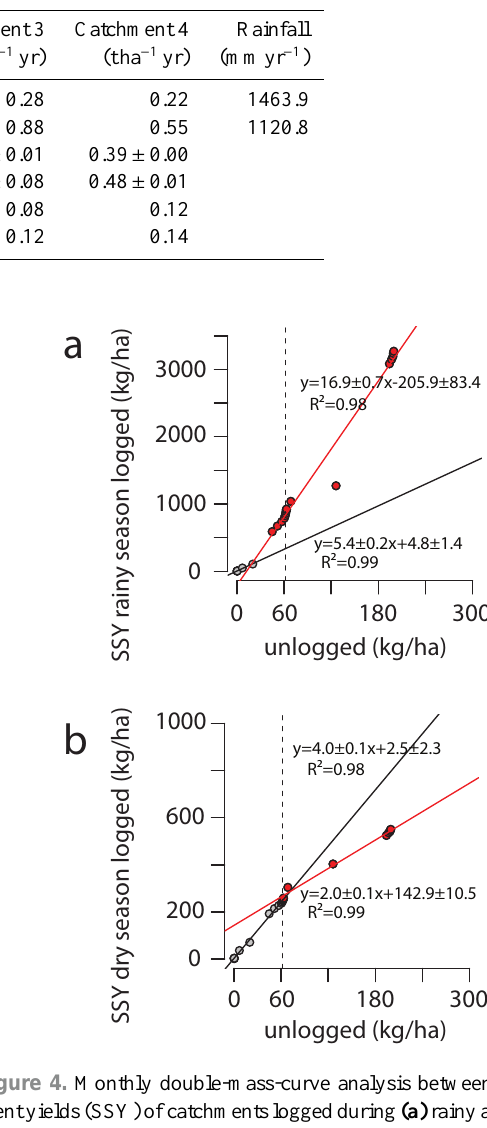
Table 2. Bulk data and modelled annual suspended sediment yields in 2009 and 2010 at the catchment outlets of control (1), rainy-season clear cutting (3), and dry-season clear cutting (4). Annual rainfalls from local rain gauge (Mohr et al., 2012); errors are ± 1 standard deviation.